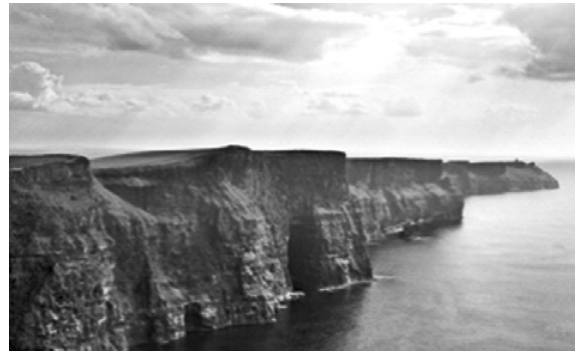
Fig. 1. Cliffs of Moher in Ireland reach up to 214 m Source : from